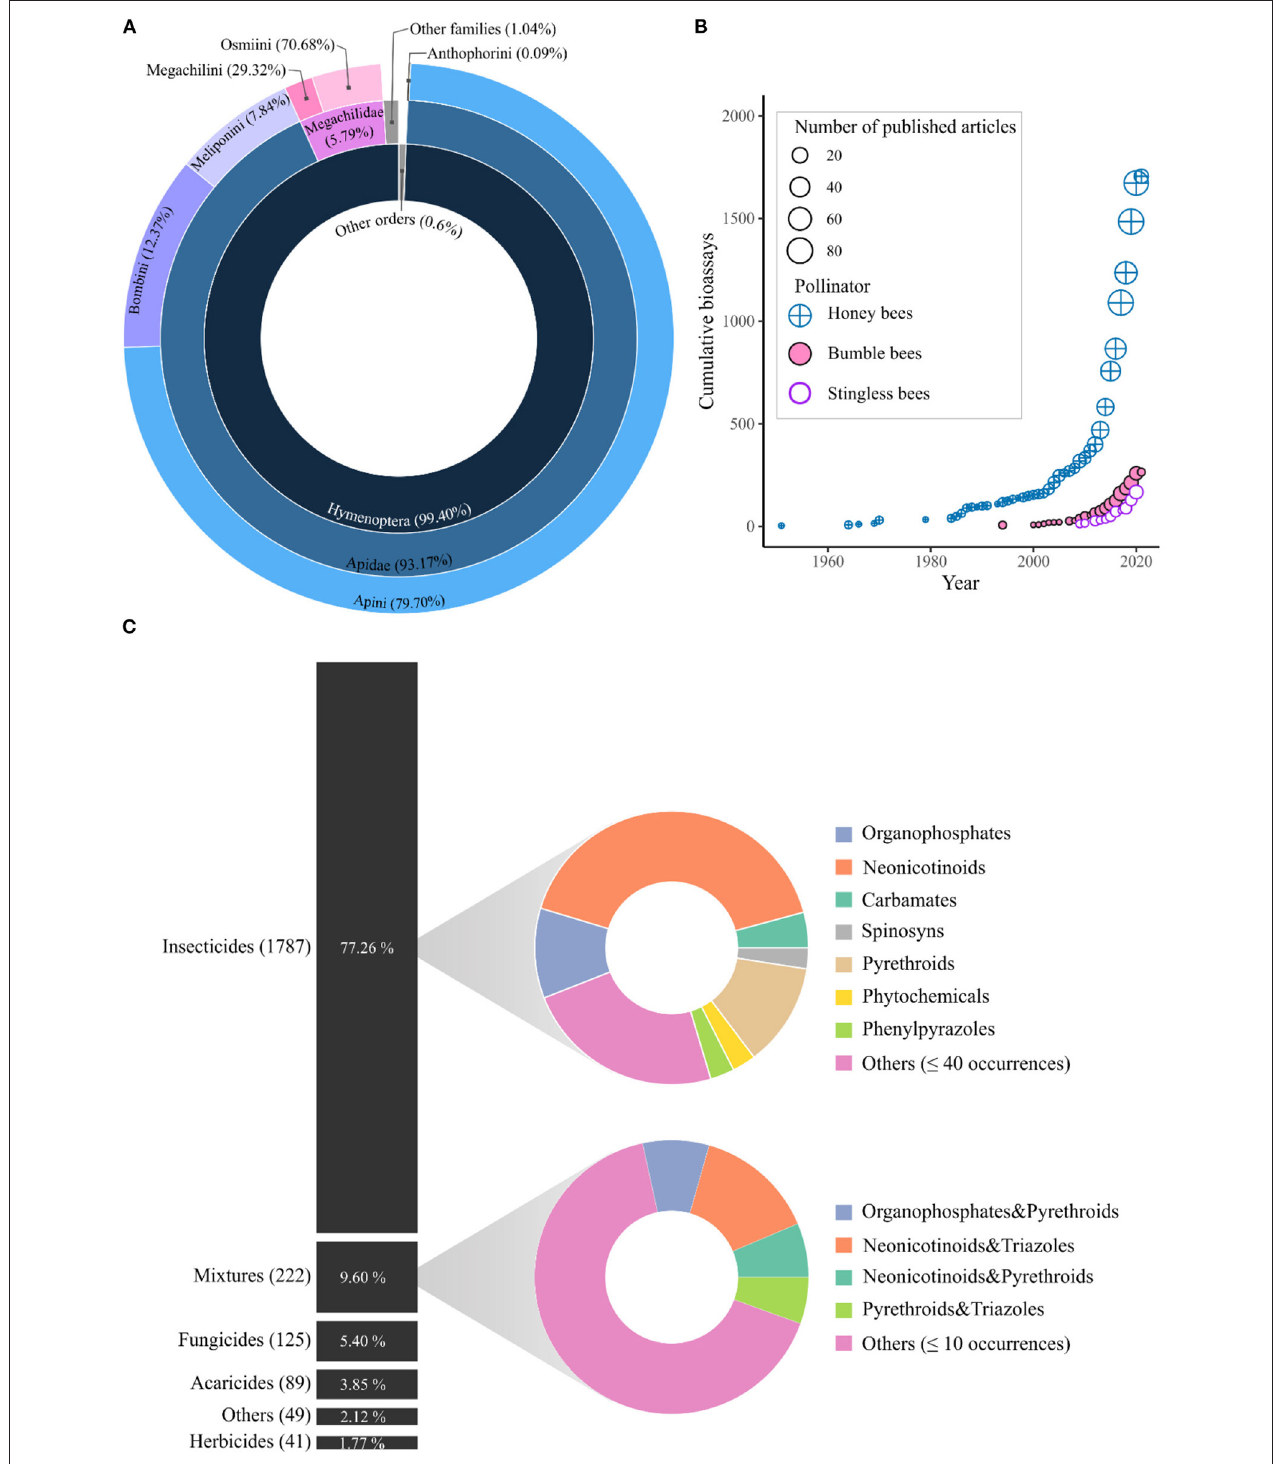
FIGURE 2 | Overall trends in publications on toxicological assessment of agrochemicals for insect pollinators. (A) Distribution of bioassays according to pollinator groups; the circle in the center represents the root node, with the hierarchy moving outward from the center. (B) Cumulative independent bioassays (i.e., a single study assessing a different agrochemical stressor or pollinator in independent trials) over time exhibiting the number of published articles per year and the main groups of pollinators (bees). (C) Agrochemical groups evaluated in the published articles, detailing the insecticides and mixtures (i.e., mix of two or more agrochemical groups) comprising the main groups. Agrochemicals, insecticides, and mixtures with occurrences ≤ 40, ≤ 40, and ≤ 10 were grouped as “others,” respectively.